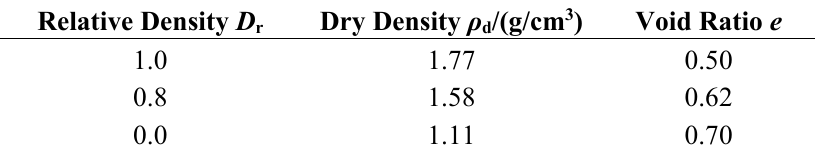
Figure 2. Grading curve for the screened quartz grains. Table 1. The parameters of the quartz